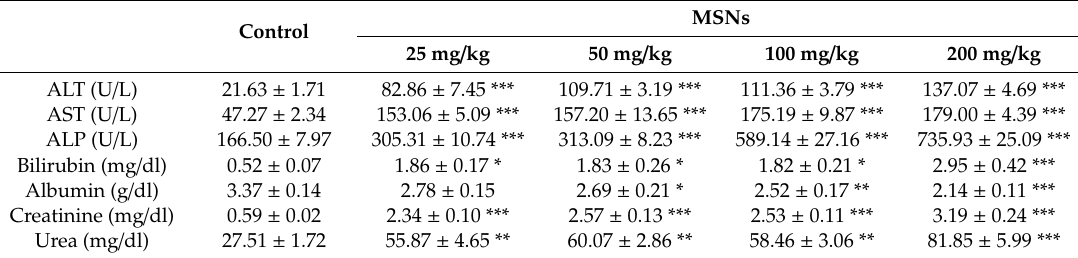
Table 2. E ff ect of MSNs on liver and kidney function markers in